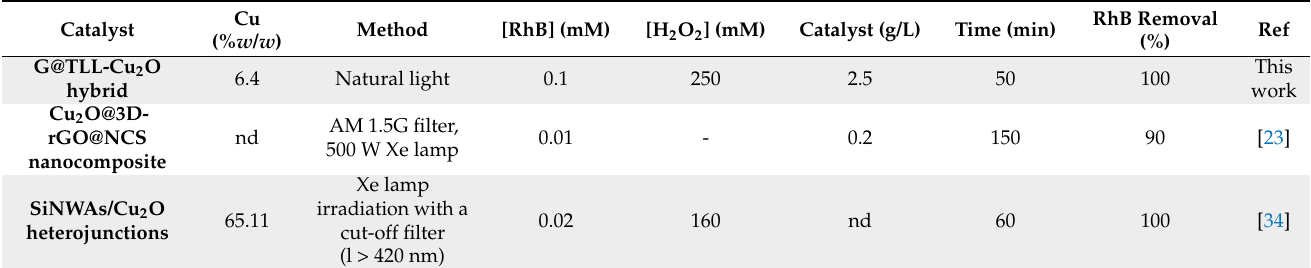
Table 1. Comparative in the degradation of Rhodamine B (RhB) by different